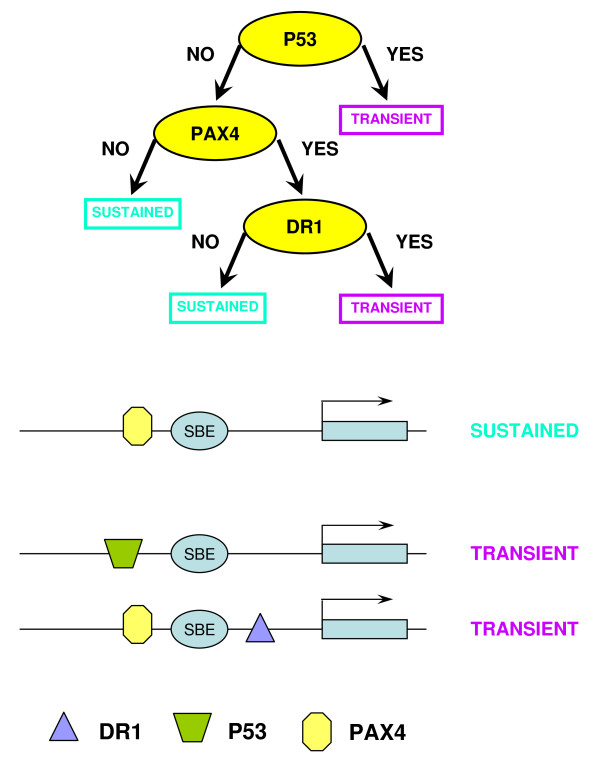
Classification model that discriminates sustained and transient TGF-β/SMAD targets within the up-regulated group. Upper panel shows the CART model and lower panel shows the derived cis-regulatory modules of these target genes identified by the CART model.